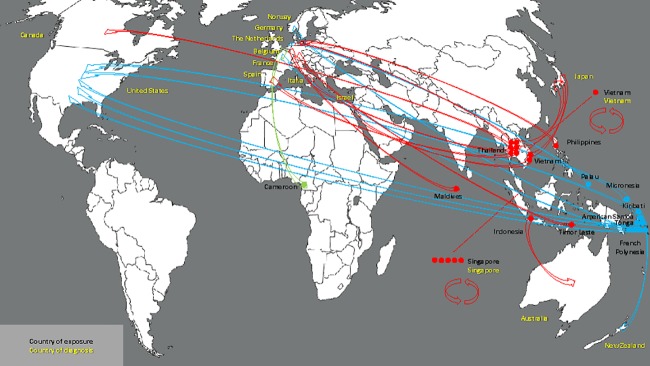
Place of exposure and place of diagnosis (arrows) of GeoSentinel Zika patients from Africa (green dot), Asia (red dots), and the Pacific (blue dots)—Circular arrows indicate cases in international travelers who contracted Zika while abroad and were diagnosed in the country of exposure while traveling.Linear arrows indicate cases in international travelers who contracted Zika while abroad and had their diagnosis confirmed on returning to their home country.—Base map is available free of charge from http://www.histgeo.ac-aix-marseille.fr/ancien_site/carto/.